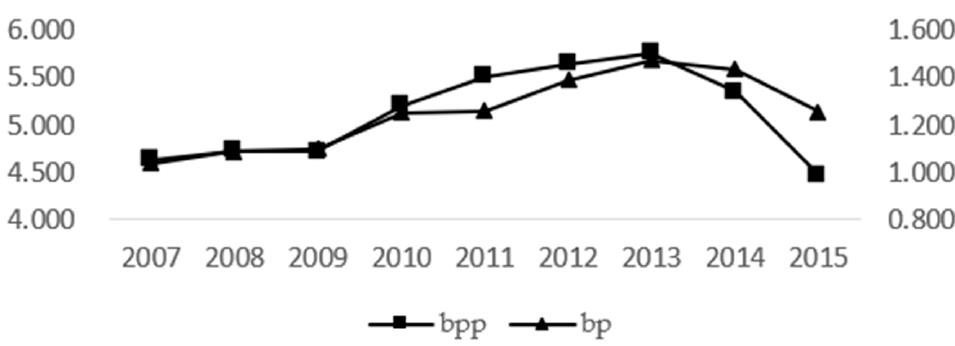
Figure 3. Changes in the two governance uncertainty indices during the study period.